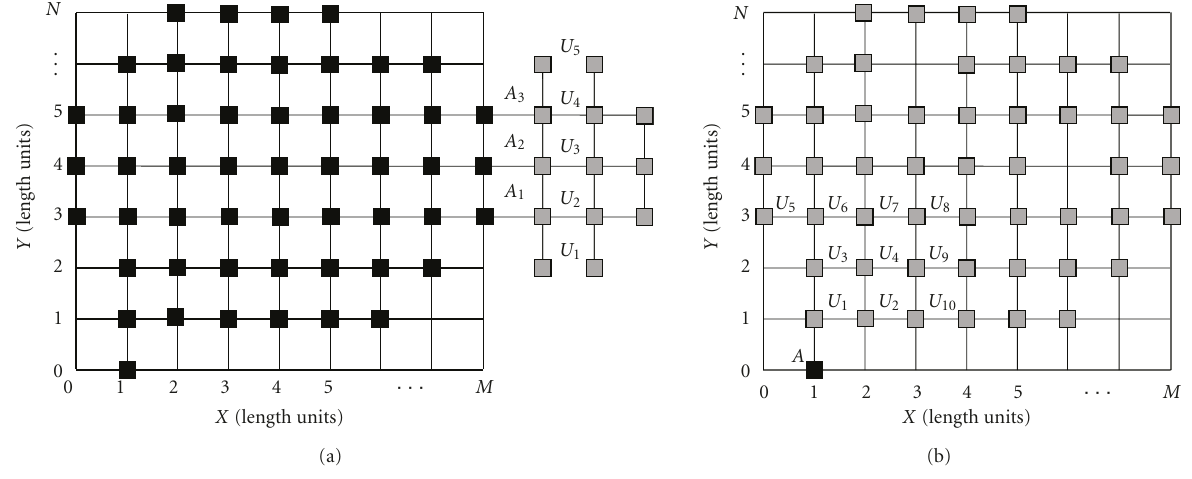
Figure 4: Schematic of Kcdlocation algorithm